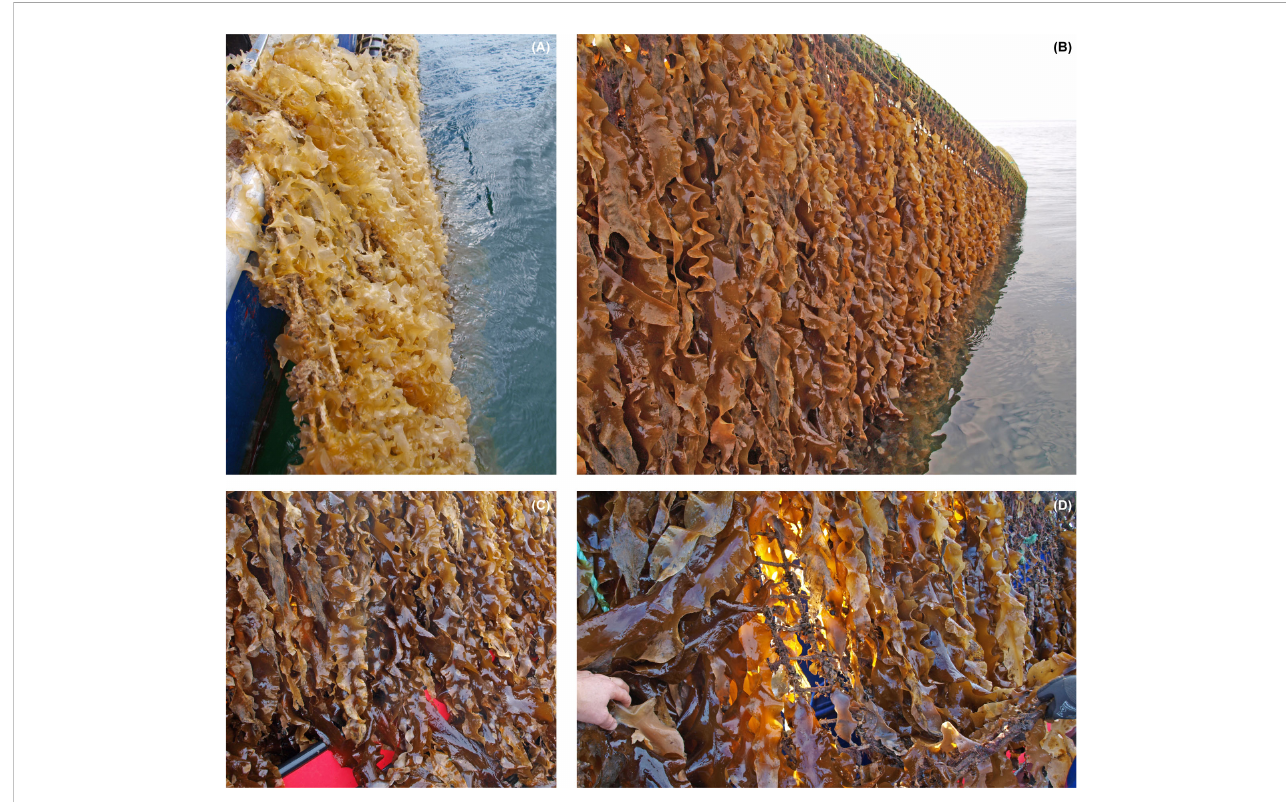
FIGURE 11 Biomass S. latissima on the net system (A) in May 2019, (B) June 2020, and (C, D) a close up of the biomass on the net in June